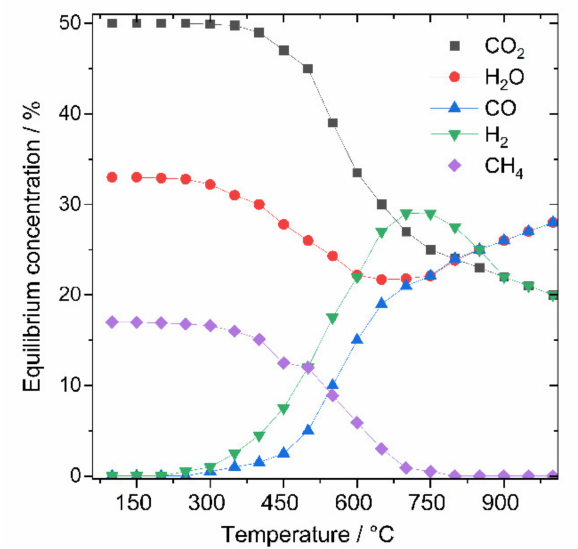
Figure 2. The thermodynamic equilibrium composition of different products of the conversion of CO 2 /H 2 (1:1) at ambient pressure in the temperature range from 100 to 1000 ◦ C (reprinted with permission from Ref. [22] © 2020, Frontiers, Lausanne,